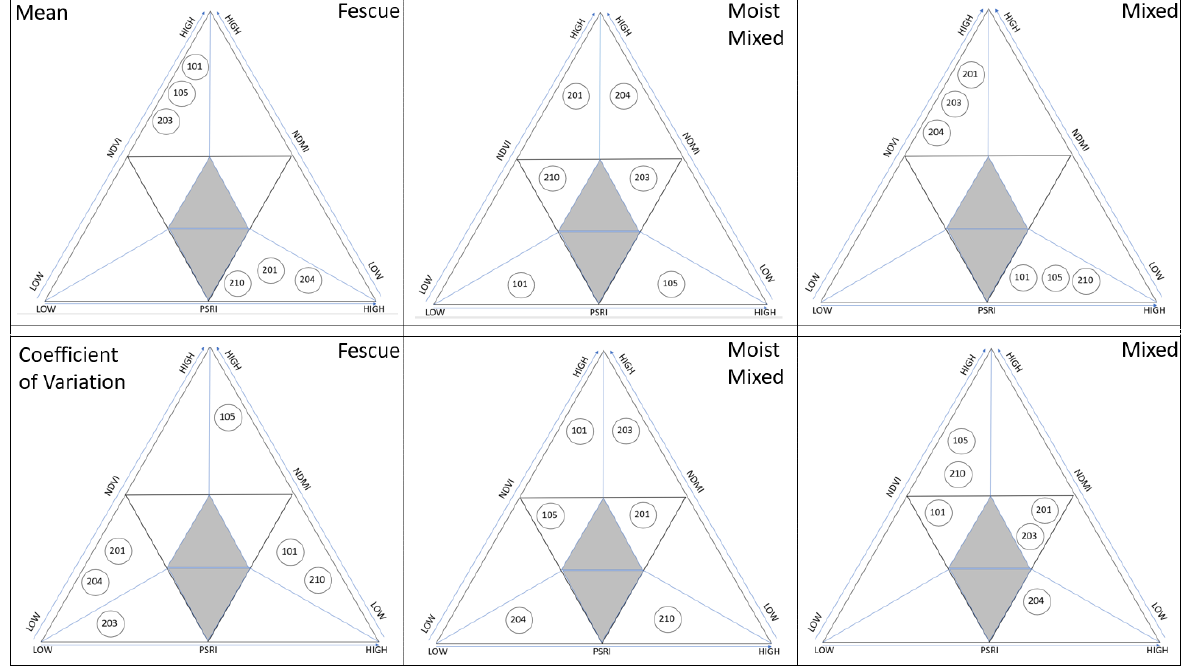
Figure 9. Comparative triangles based on vegetation index mean and coefficient of variation values for the Fescue, Moist-Mixed, and Mixed Ecoregions. 101 = Native Grassland; 105 = Native Modified; 201 = Hay Alfalfa; 203 = Hay Grass; 204 = Hay Mixture; 210 = Pasture.